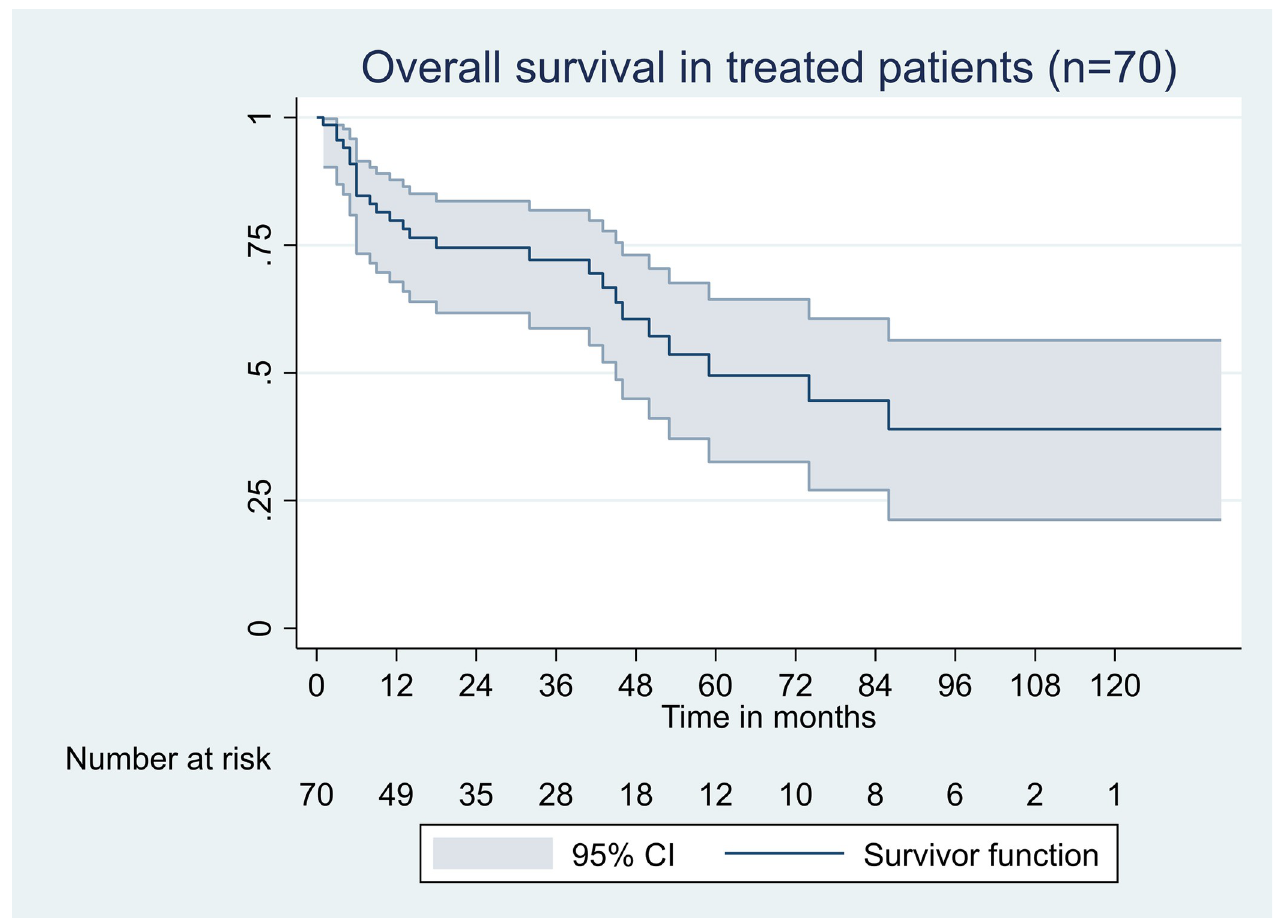
Fig 2. Overall survival in treated